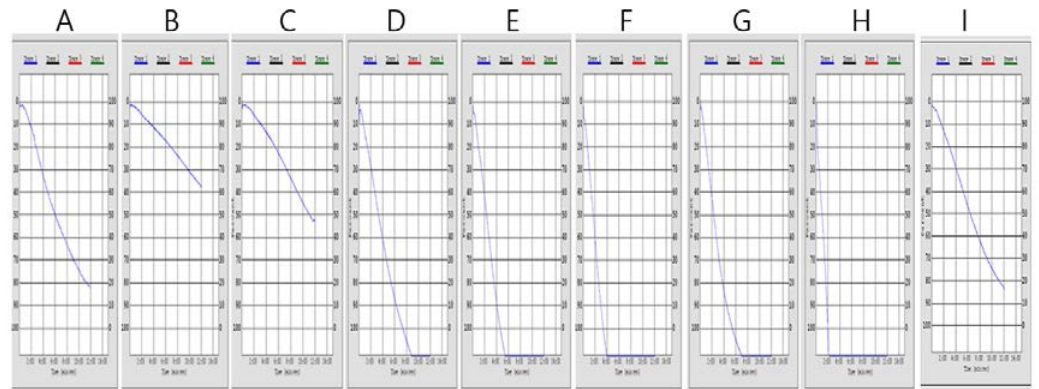
1 PAR: Platelet Aggregation Ratio. Data are presented as representative results relative to three independent determinations. Amplitude is expressed as ohms by maximum extent of platelet aggregation, and slope (rate of reaction) is determined by drawing a tangent through the steepest part of curve. Area under the curve (AUC) was calculated from the platelet aggregation curve.